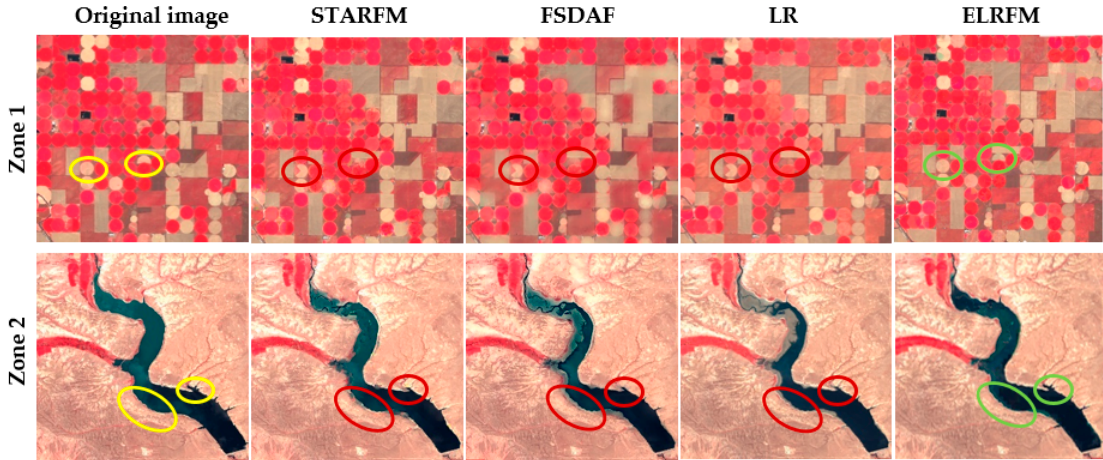
Figure 9. Comparison of the original Sentinel-2 image (near infrared, red, green bands as RGB) and the predictions of different fusion methods for the other two test areas.